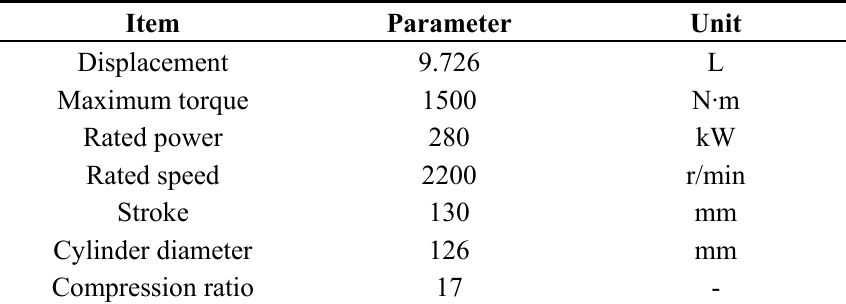
Table 2. Main parameters of the diesel engine.